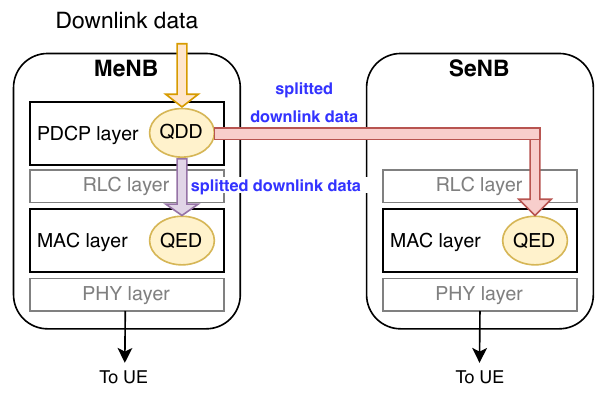
Figure 3. The proposed